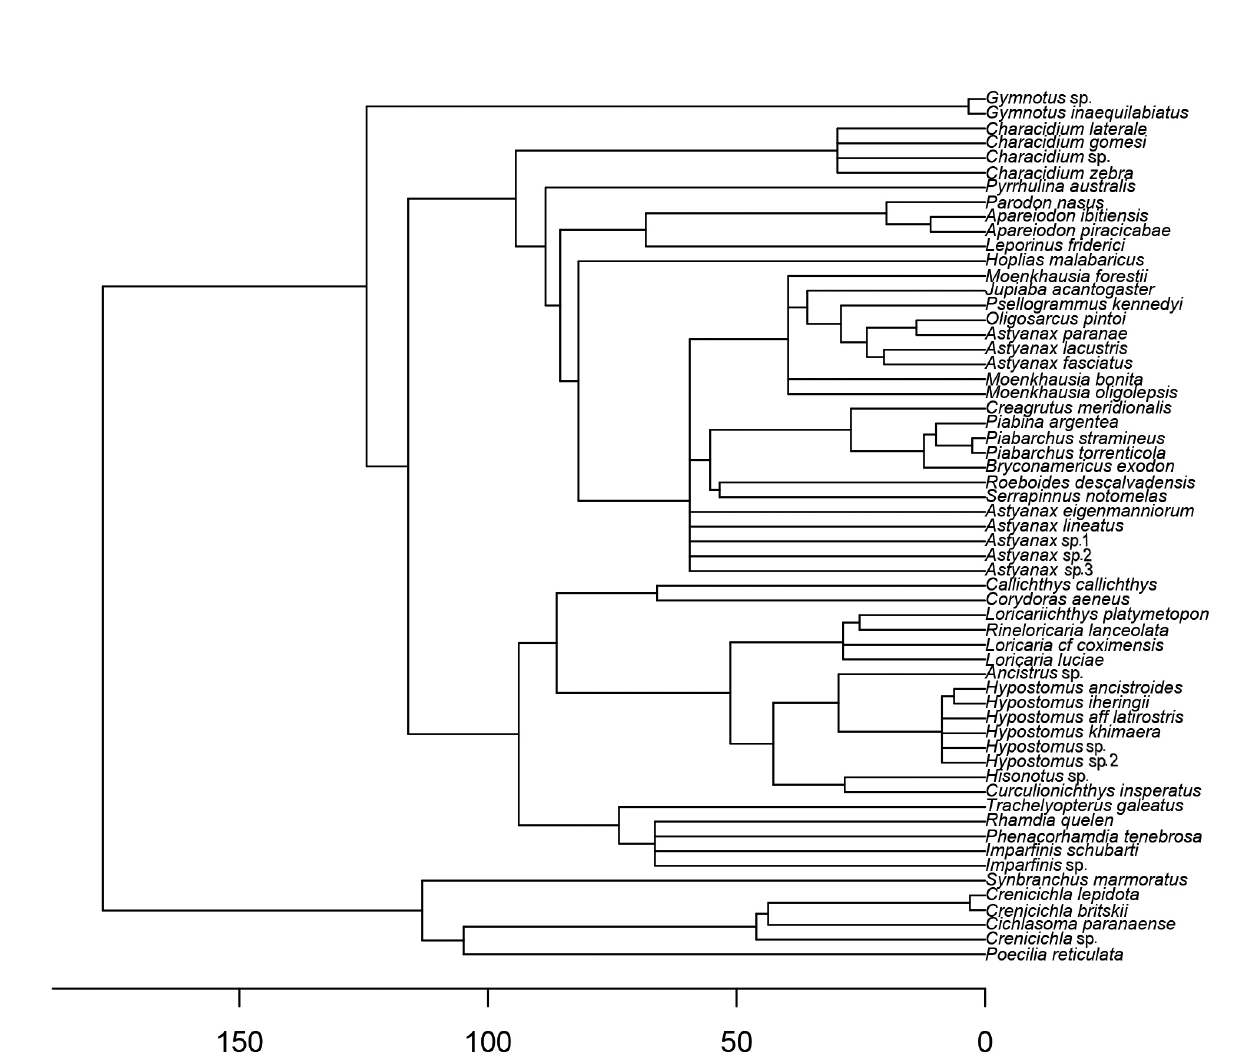
FIGURE 2 | Phylogenetic hypothesis for fish collected in headwater streams of the Paraná and Paraguai River